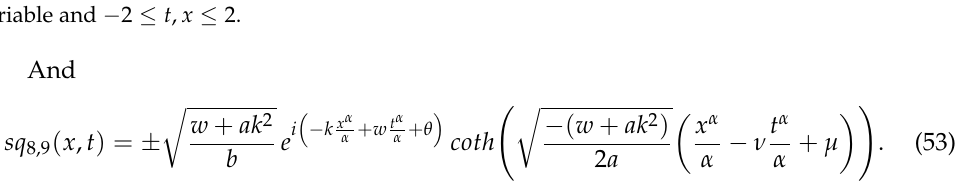
Figure 4. The first and second moments for the random solution sq 7 in (52); α is a beta random variable and − 2 ≤ t , x ≤